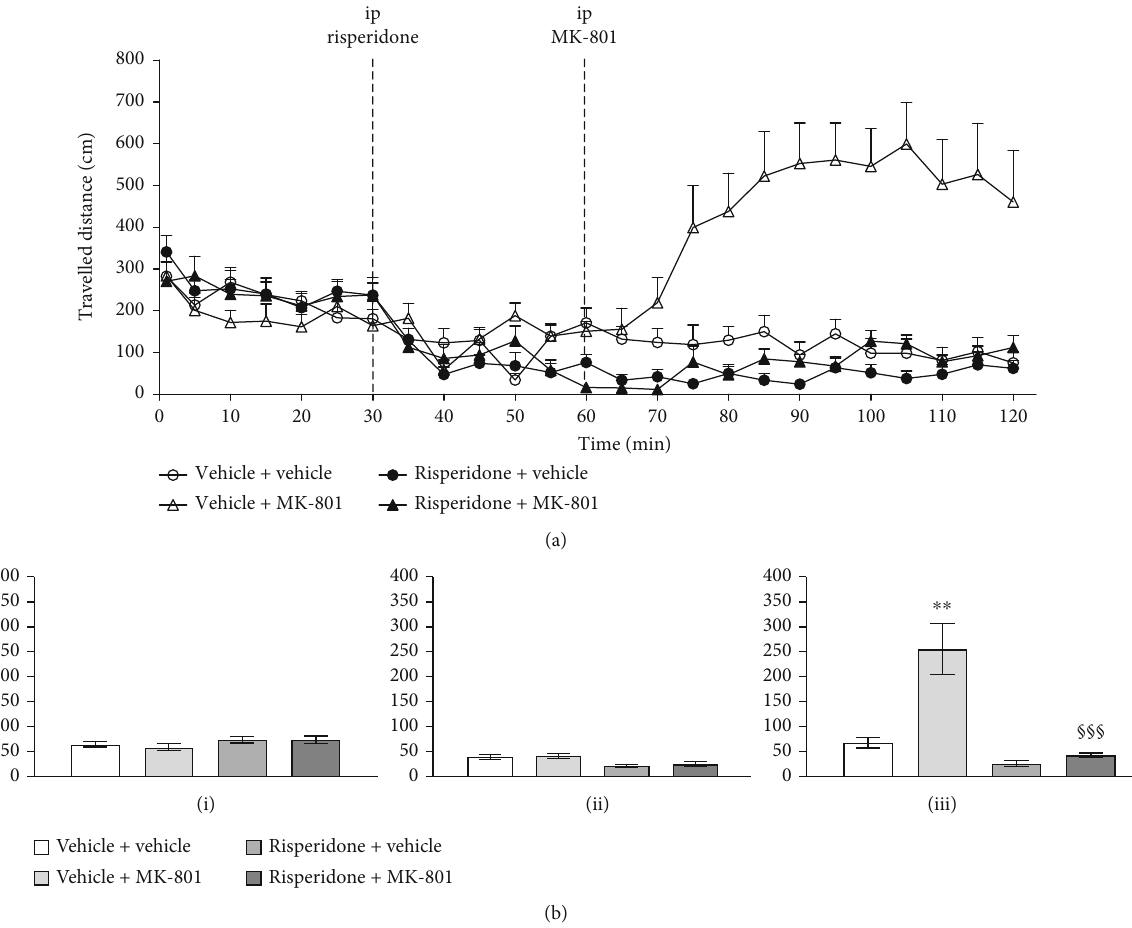
Figure 1: The travelled distance (cm) at the corresponding time points in the open fi eld test following the risperidone and MK-801 injection (a). Comparisons of the total travelled distance (m) for each drug treatment group (b); vertical bars represent SEMs: (i) represents baseline within 0 – 30 minutes, (ii) represents risperidone drug e ff ect during 30 – 60 minutes, and (iii) represents MK-801-injected travelling change during 60 – 120 minutes; total travelled distances are shown in meters. Subject numbers were 9 – 10 in each group. Di ff erences among the study groups were evaluated by ANOVA and post hoc analysis. Statistically signi fi cant di ff erences between groups: ∗ p < 0 : 05 , ∗∗ p < 0 : 01 , and ∗∗∗ p < 0 : 001 vs. vehicle +vehicle; § p < 0 : 05 , §§ p < 0 : 01 , and §§§ p < 0 : 001 vs. vehicle+